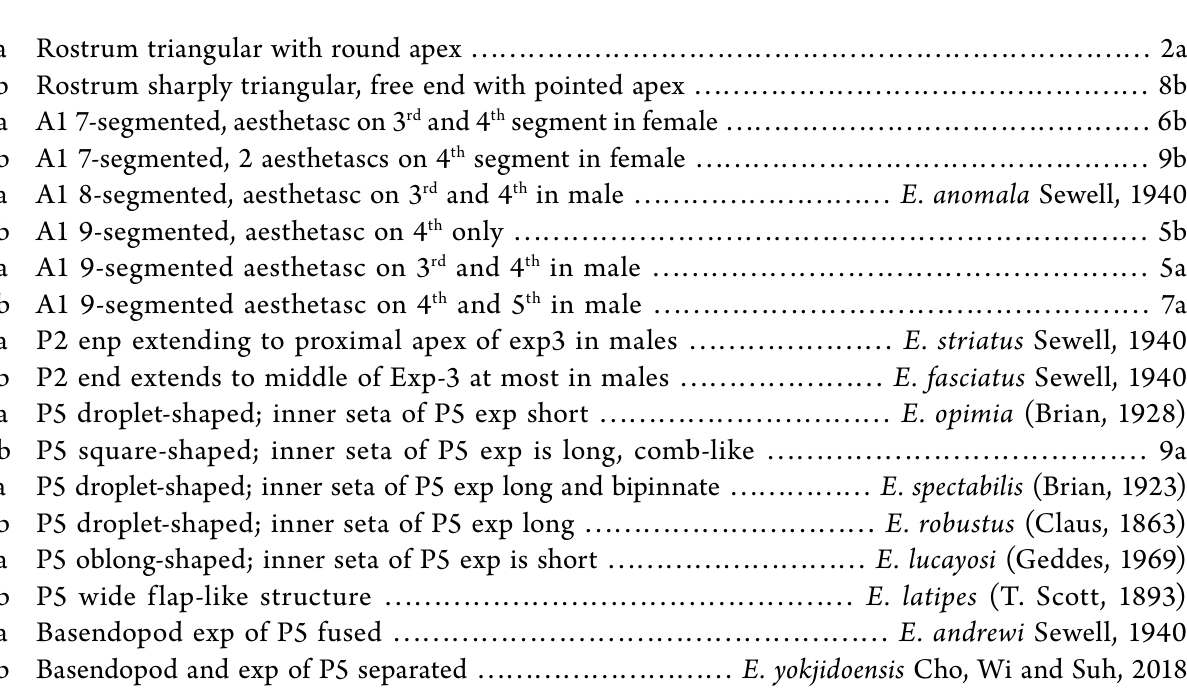
Key to the species of